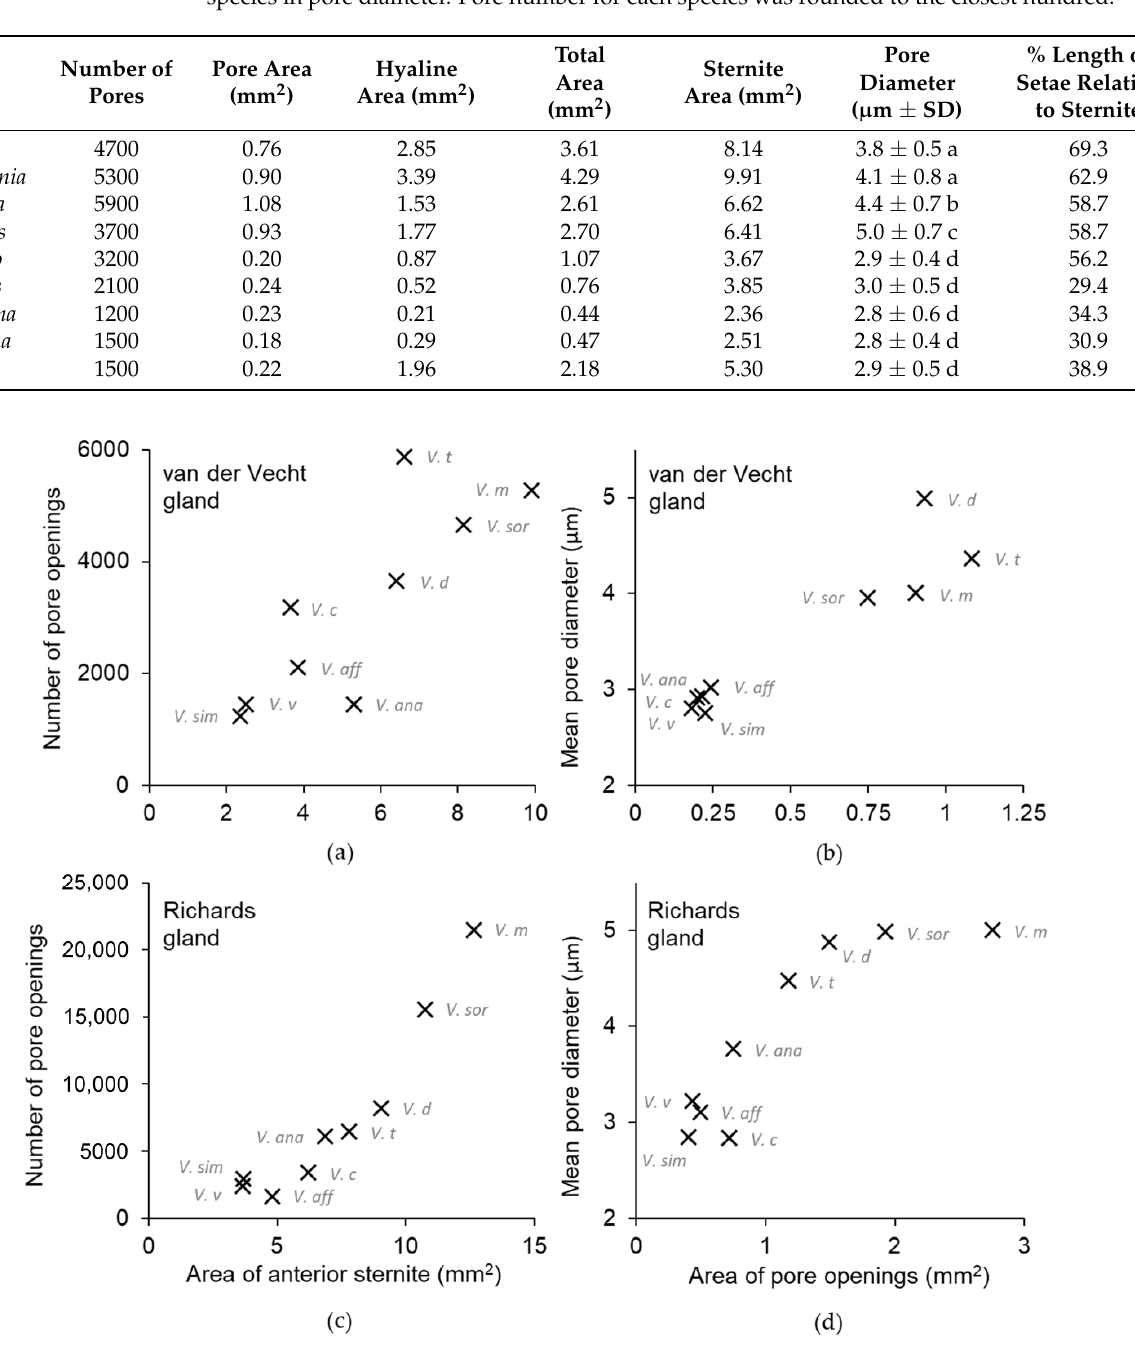
Table 2. Size of features associated with the van der Vecht gland for nine Vespa species. Focal species are presented in the order in which they appear in the phylogeny depicted in Figure 1. Pore number includes both lateral clusters. Total area of gland-associated structures includes pore openings and the hyaline region containing the sternal brush. Sternite area extends from its anterior margin to the posterior margin of the smooth cuticle; setal length is given as a percentage of the distance at the midline between the aforementioned cuticular margins (see Figure S1). All estimates were pooled across images of specimens within species. Different letters indicate significant differences among species in pore diameter. Pore number for each species was rounded to the closest hundred.